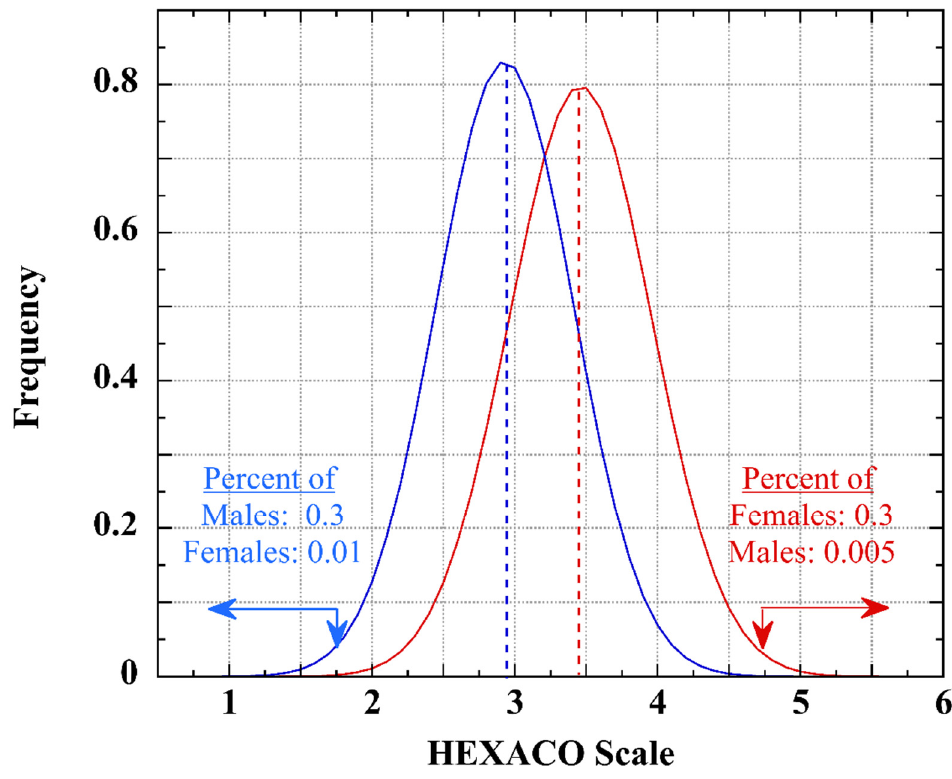
Figure 9. Gaussians displaying the idealized population average distribution of HEXACO Emotion- ality for college-age female (red) or male (blue) students (Lee and Ashton, 2006) The dashed lines mark the means (F: 3.43; M: 2.96). One standard deviation above the female mean (>4.07) defines 16% of high-E individuals. In the ≥ 2 σ high-E tail of the distribution of females, males are comparatively outnumbered by ≥ 60:1. Likewise, in the ≤ 2 σ low-E tail of the distribution of males, females are comparatively outnumbered by ≥ 30:1.